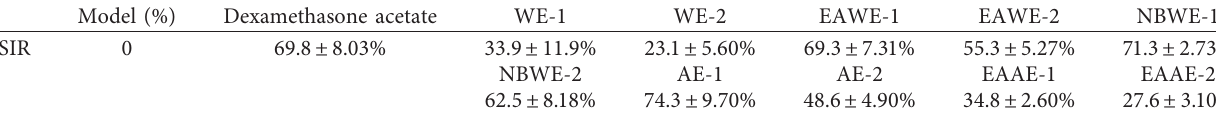
Table 2: Anti-inflammatory activity of 10 Qing Jin Hua Tan Tang